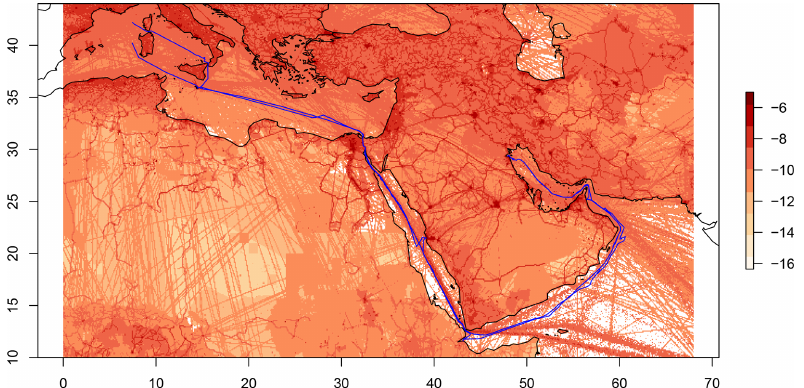
Figure A2. CO 2 emissions predicted by EDGAR v4.3.2 for year 2012 in the Mediterranean and Middle East, expressed in log10(kgCO 2 m − 2 s − 1 ). The ship trajectory is shown in blue.